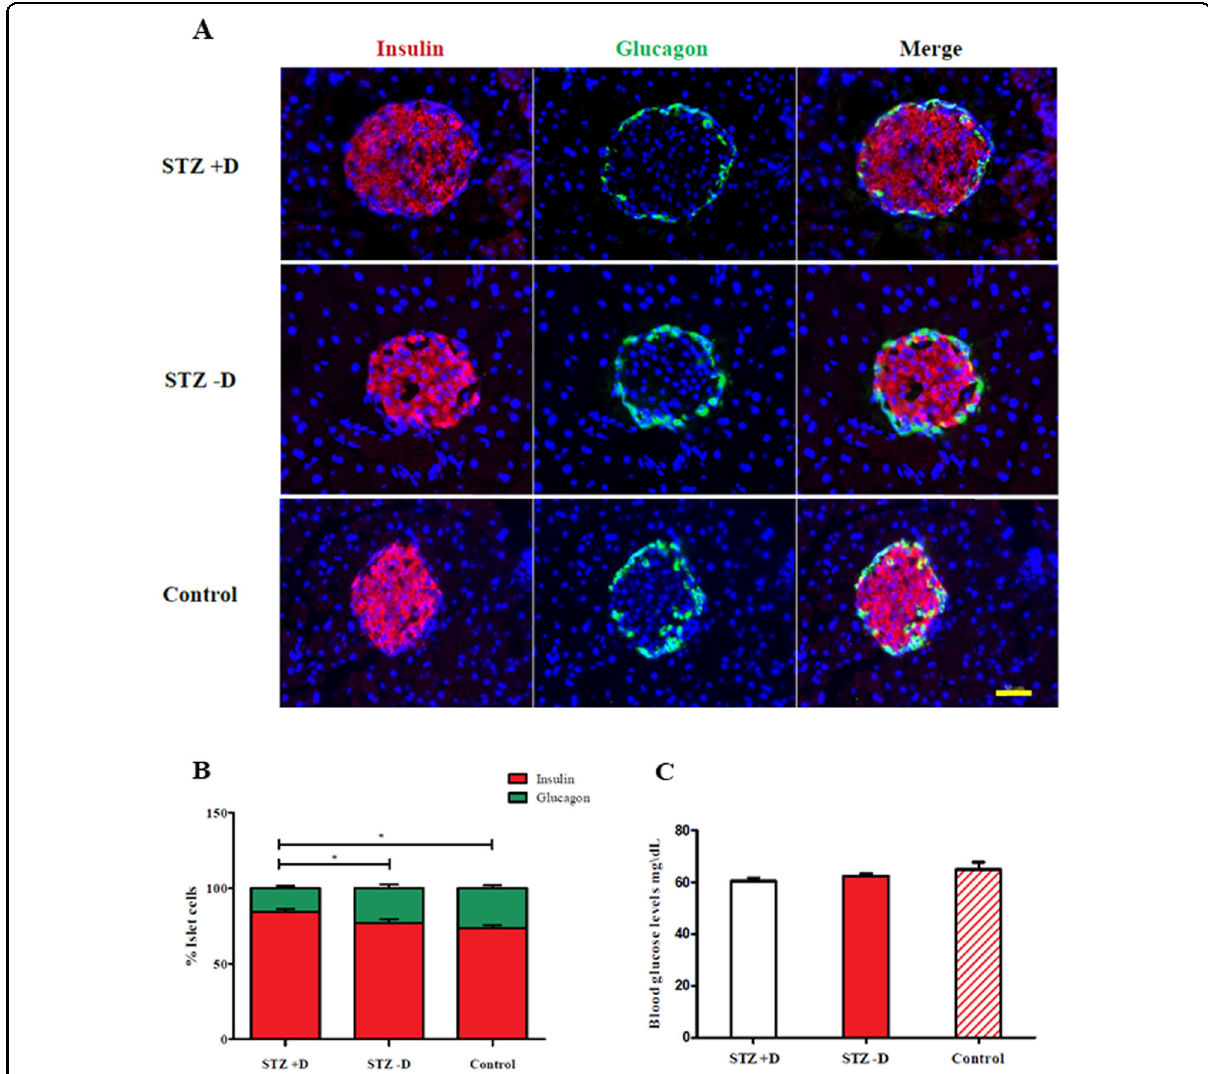
Fig. 2 Effects of STZ treatment on pancreas of offspring. A Immuno fl uorescence staining of the STZ + D, STZ − D and Control offspring ’ s pancreata. Insulin in red, Glucagon in green and DAPI in blue. scale bar = 50 µm. B Comparing the percentage of islet cells in all groups. n = 30 STZ + D, n = 22 STZ − D and n = 16 control. * p < 0.05. C Blood glucose levels of all groups ’ offspring. n = 23 STZ + D, n = 22 STZ − D and n = 22